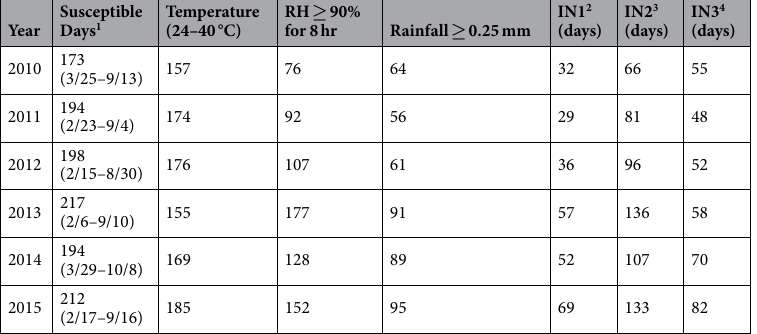
Table 1. Weather and Susceptibility Data associated with ‘Valencia’ orange groves surveyed in Florida for citrus black spot caused by Phyllosticta citricarpa . 1 Susceptible Days are the number of days when fruit are on the tree and are considered susceptible to infection by Phyllosticta citricarpa (between fruit set and 5 month post fruit set (mpfs)). Dates in brackets represent the estimated date of earliest fruit set and latest date of susceptibility at 5 mpfs. 2 IN1 = RH ≥ 90% for 8 hr + Total daily rainfall ≥ 0.25 mm + Temperature (24–40 °C) + Susceptible